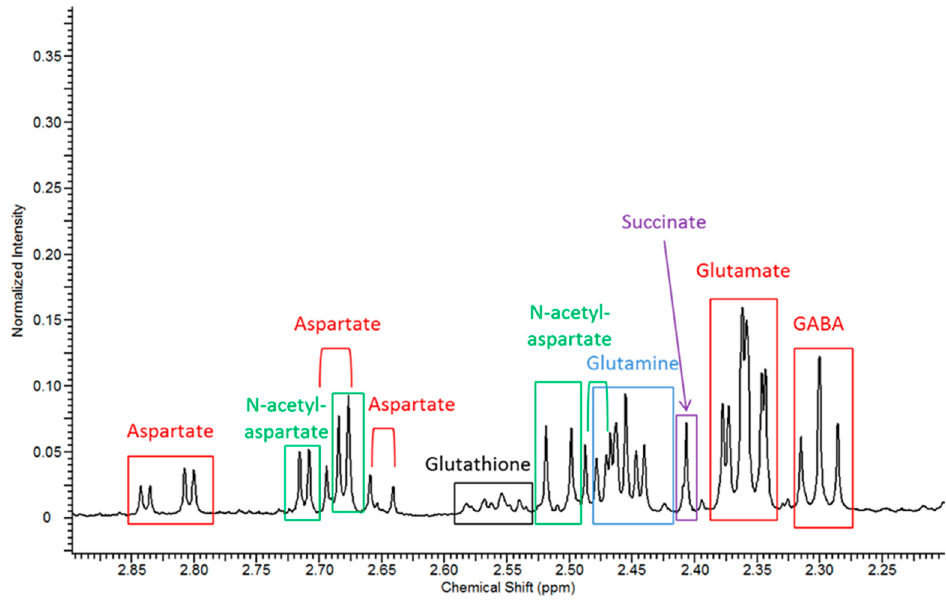
Figure 6. Expanded region (2.20–2.90 ppm) from the 1 H-NMR spectrum of cerebrum tissue from a four-month-old control mouse showing the presence of resonances for three neurotransmitters (labelled in red), GABA, glutamate and aspartate, as well as succinate, glutamine, glutathione and the neuro-axonal marker N -acetylaspartate.